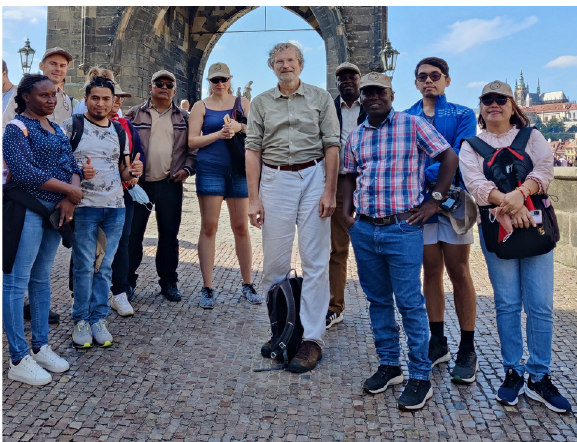
Figure 1. Excursionists at Expedition in the his- torical center of Prague. Radek Mikuláš (center) explains the local origin of the vast majority of historical building materials in medieval Prague. The pinkish limestone from which the pavement is made comes from the oldest continuously operating quarry in Europe, the Radotín - Cikánka site (Lower Devonian, Pragian